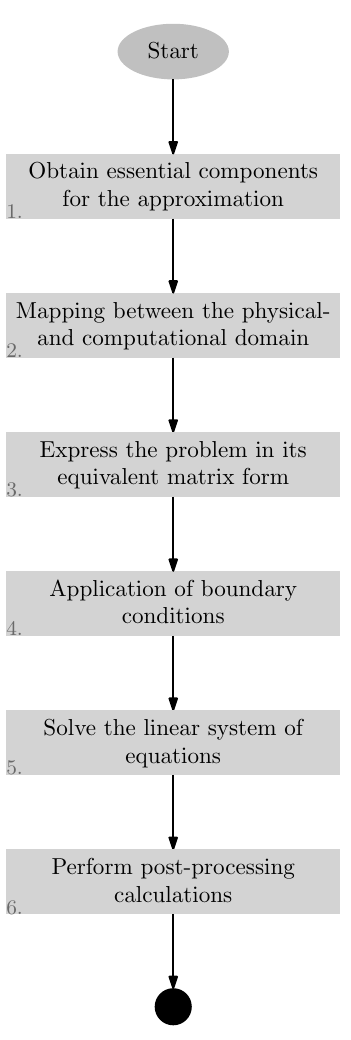
Figure 3. Flowchart of the six main processes in the